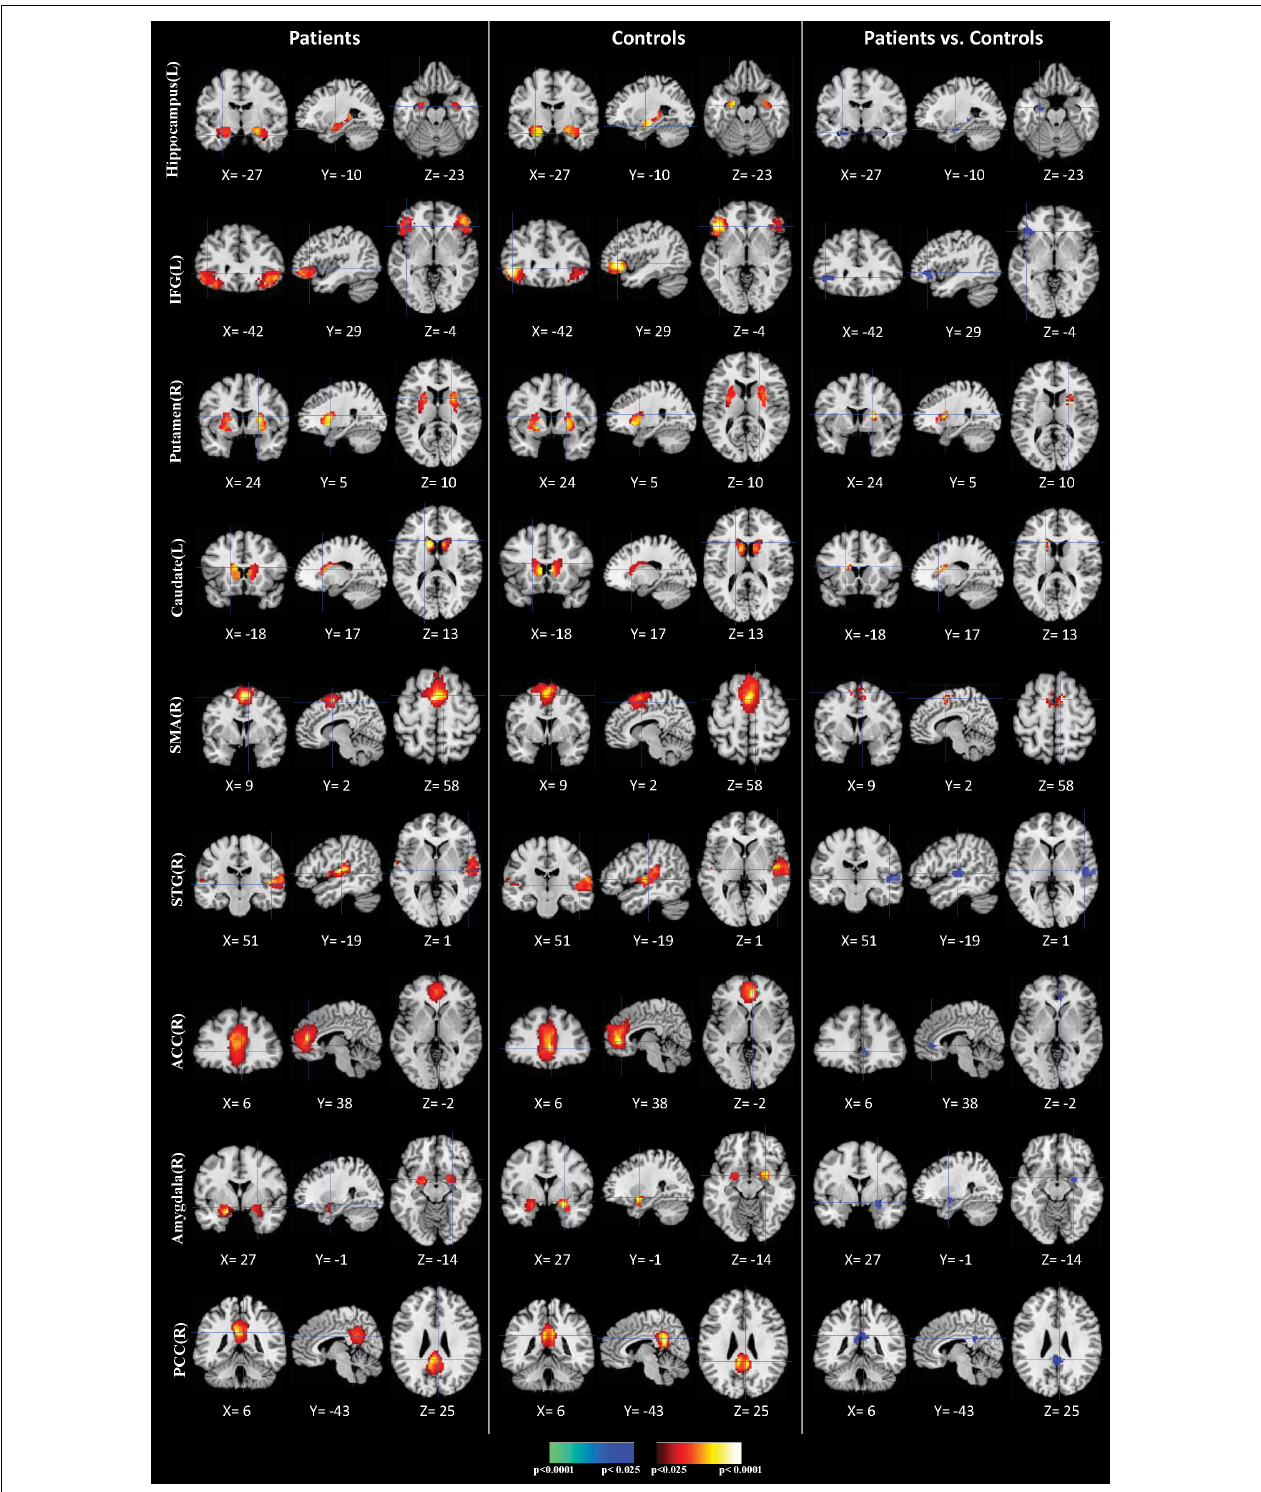
FIGURE 1 | Comparisons of brain connectivity between patients and controls. The first three columns display the connectivity maps detected from the patients group. The second three columns display the connectivity maps detected from the controls group. The last three columns display t -contrast maps comparing the group connectivity maps from the patients and controls. IFG, inferior frontal gyrus; SMA, supplementary motor area; STG, superior temporal gyrus; ACC, anterior cingulate cortex; PCC, posterior cingulate cortex.